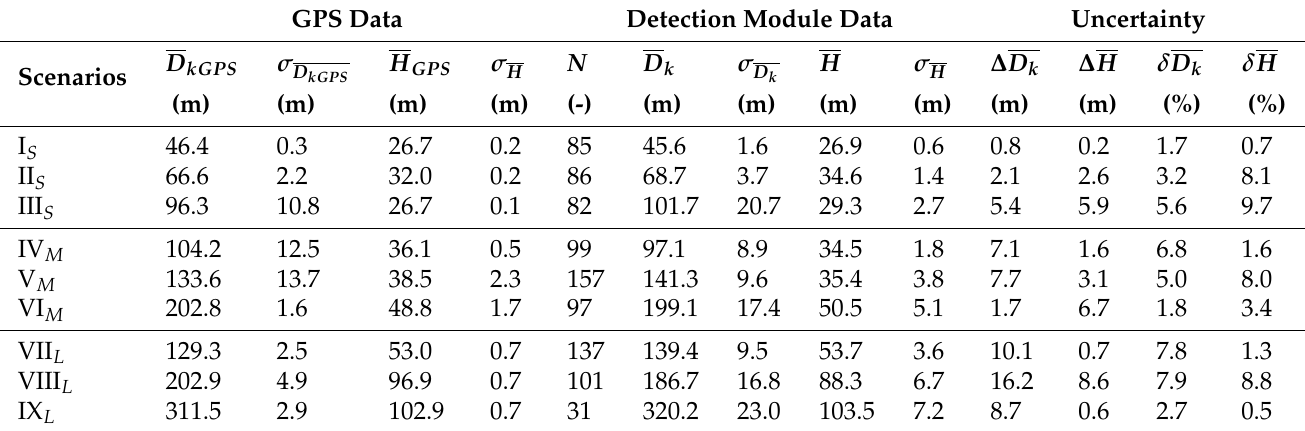
Table 5. Test plan of the designed system. N is the number of samples registered during the test, and the error is the difference in the mean between the GPS and the system measurements.